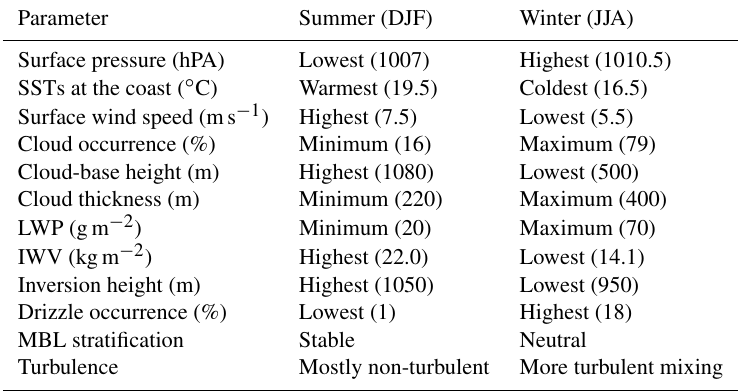
Table 3. Summary of the major findings of the present work during the Iquique Airport observations (2018/2019) for austral winter (JJA) and summer (DJF). Values represent seasonal